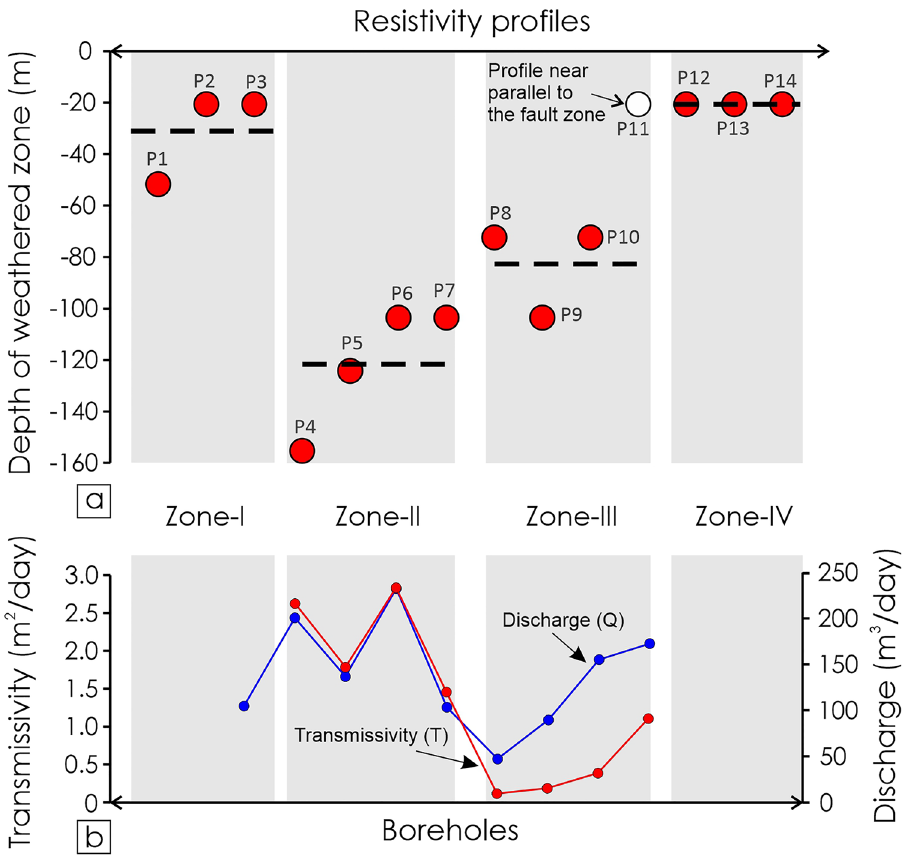
Figure 18. ( a ) Weathered zone depth in different zones estimated from resistivity profiles. Red dots denote the maximum weathered zone depth for different resistivity profiles. The dotted line marked the mean weathered zone depth. Profile-11 is an outlier in Zone-III as the profile is sub-parallel to the fault zone. Therefore, the weathered zone depth for Profile-11 is discarded. ( b ) Transmissivity (T) and discharge (Q) of different boreholes for different structural zones (Zone-I, Zone-II, and